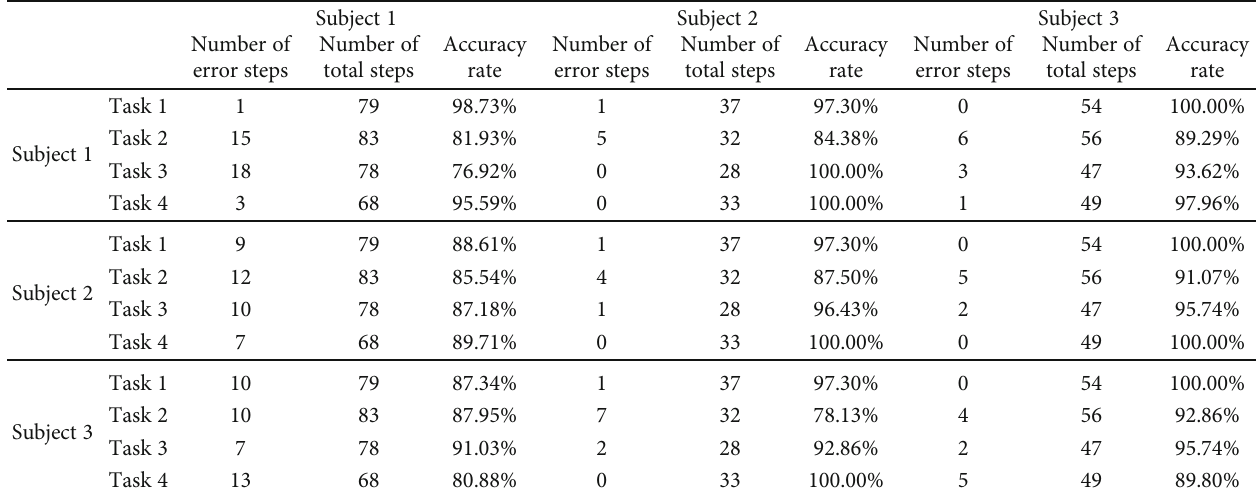
Table 5: Recognition accuracy of 1: 1 intrasubject